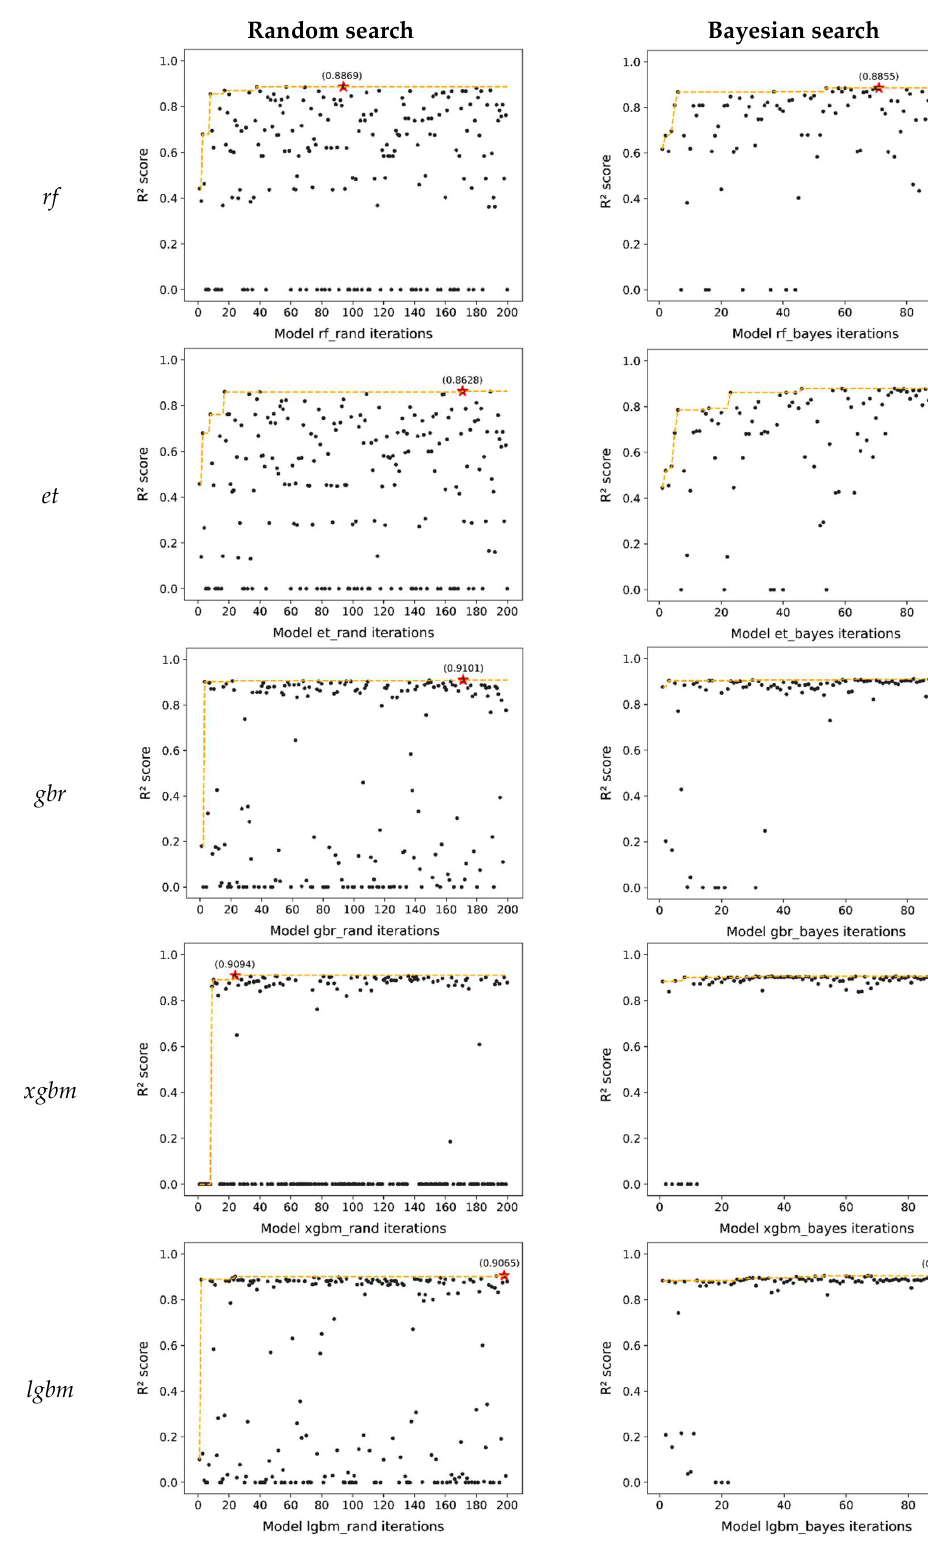
Figure 12. Learning curves for the hyperparameter search. Maximum R², • R² value of each iteration, --- Maximum cumulative R².